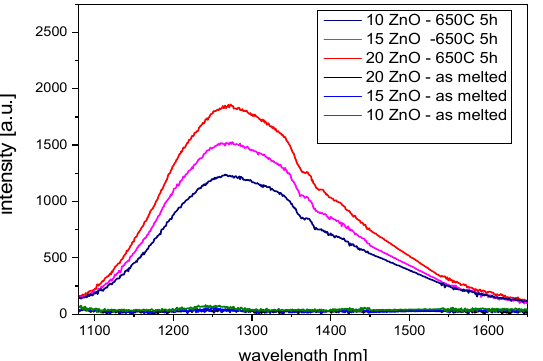
Figure 8. Infrared luminescence spectra of 0.1NiO doped GGK with glass and transparent glass- ceramics with 10, 15, and 20 ZnO (mol.%), (HT@650 ◦ C for 5 h), λ exc = 808 nm.